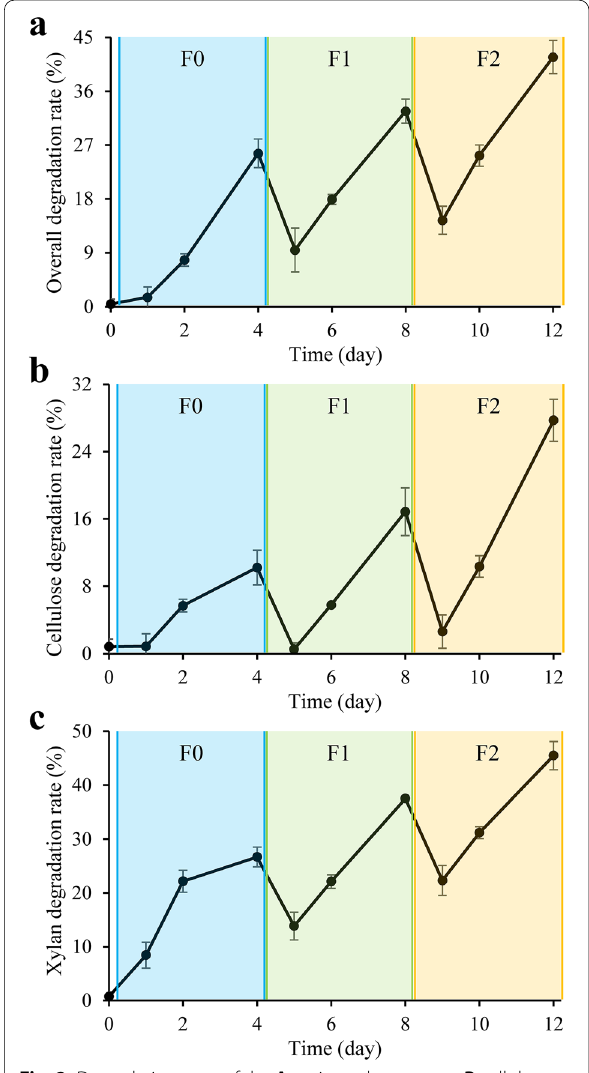
Fig. 2 Degradation rates of the A entire carbon source, B cellulose and C hemicellulose during revival Fig. 3 Evolutions of A reducing sugar, B extracellular protein and C